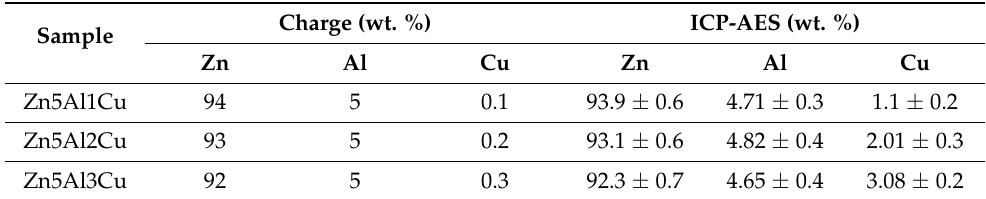
Table 1. Composition of Sn–Sb–Ti alloy and the results of chemical analysis done by the the ICP-AES method [wt. %].